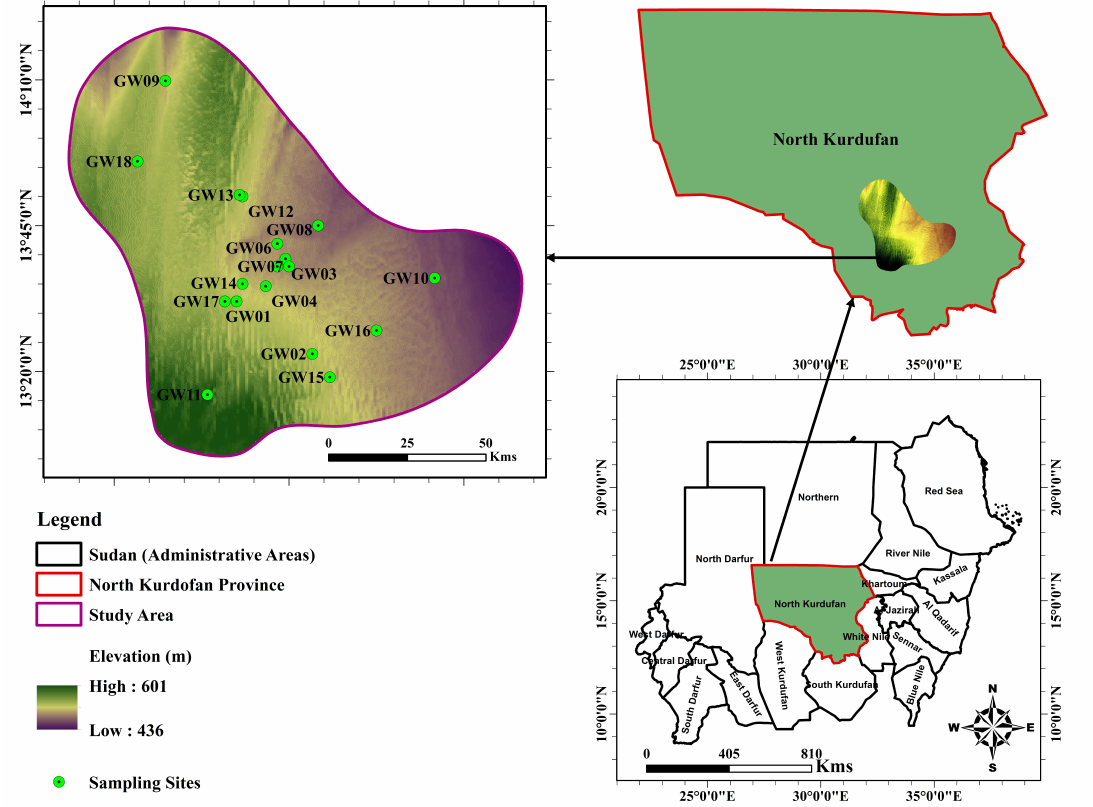
Figure 1. Map location of groundwater sampling stations of the study